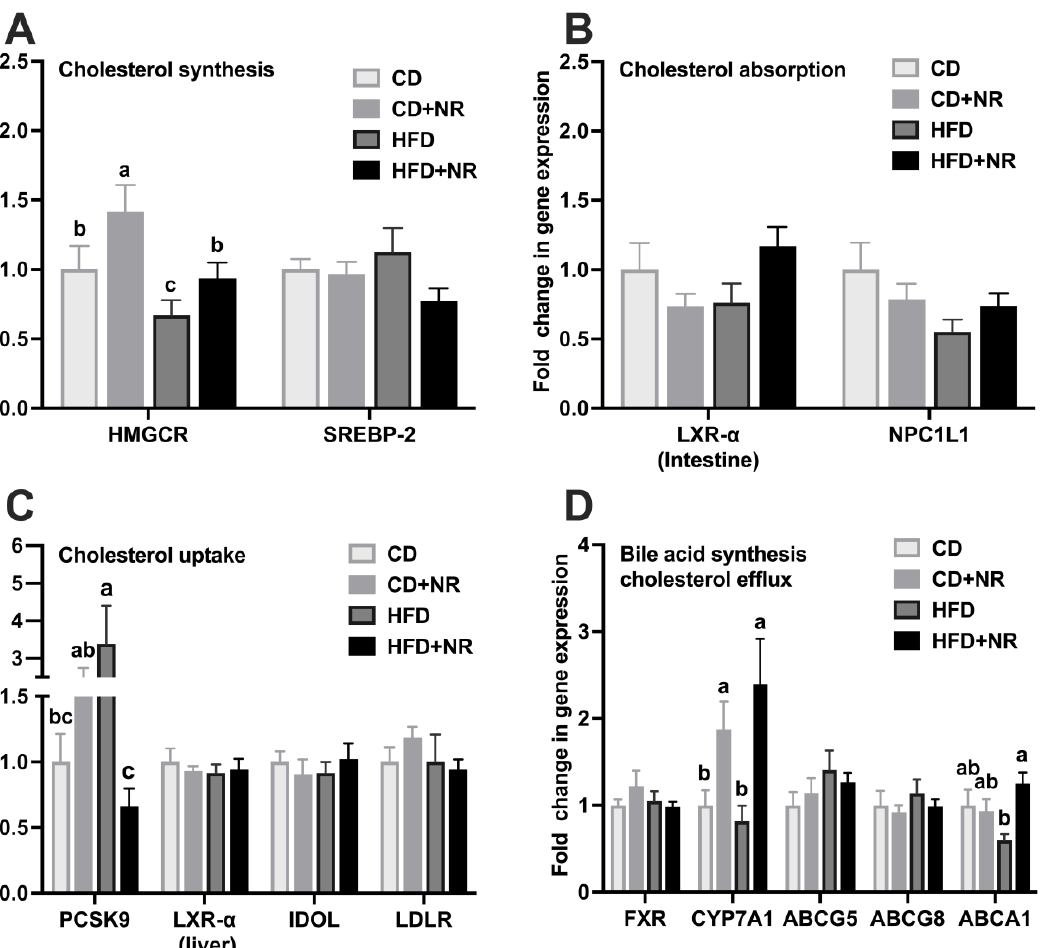
Figure 3. Gene expression of lipid metabolism pathways in ApoE −/− mice fed a CD or HFD, without or with NR at the end of the study. ( A ) Gene expression in cholesterol synthesis; ( B ) Gene expression in cholesterol absorption; ( C ) Gene expression in cholesterol uptake; ( D ) Gene expression in choles- terol efflux and bile acid synthesis. Data were presented as mean ± SEM. A statistical analysis was performed using a two-way analysis of variance (ANOVA) with the main effects of diet and NR and diet*NR interaction. Means with different letters (a, b or c) indicate a significant difference from each other. CD (control), n = 10; CD + NR, n = 11; HFD, n = 10; HFD + NR, n = 10. ABCA1, Recombi-